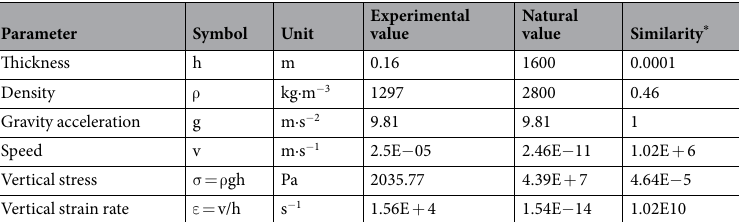
Table 2. Calculation of experimental similarity. * Calculated from the ratio between experimental value and natural